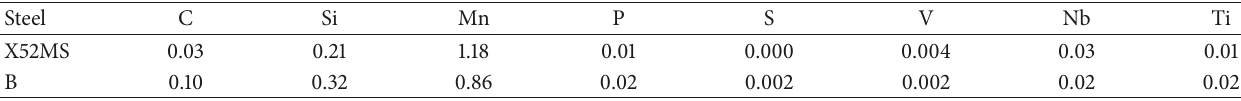
Table 1: Chemical composition of API 5L X52MS and API 5L B steels (wt.%).